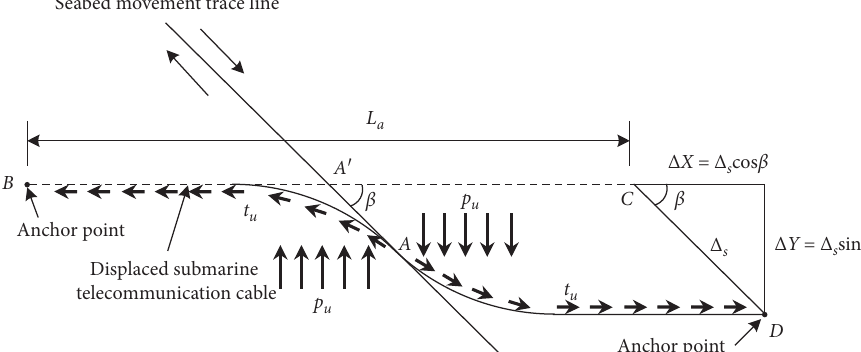
Figure 2: Plan view of a submarine telecommunication cable subjected to lateral seabed movements.